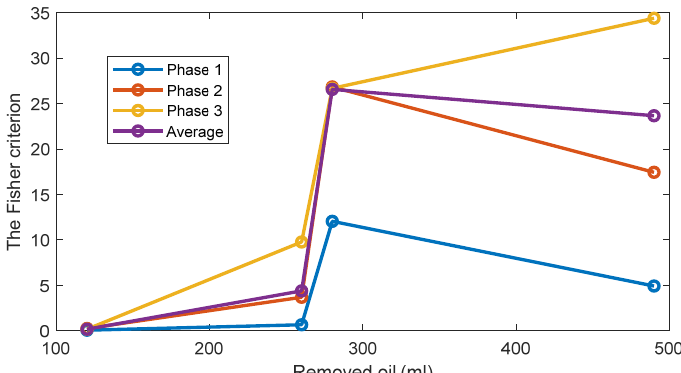
Figure A8. The TPOCD, provided by technology 2, for 3 phases and 4 levels of oil removal compared to the standard oil level (Day 2).